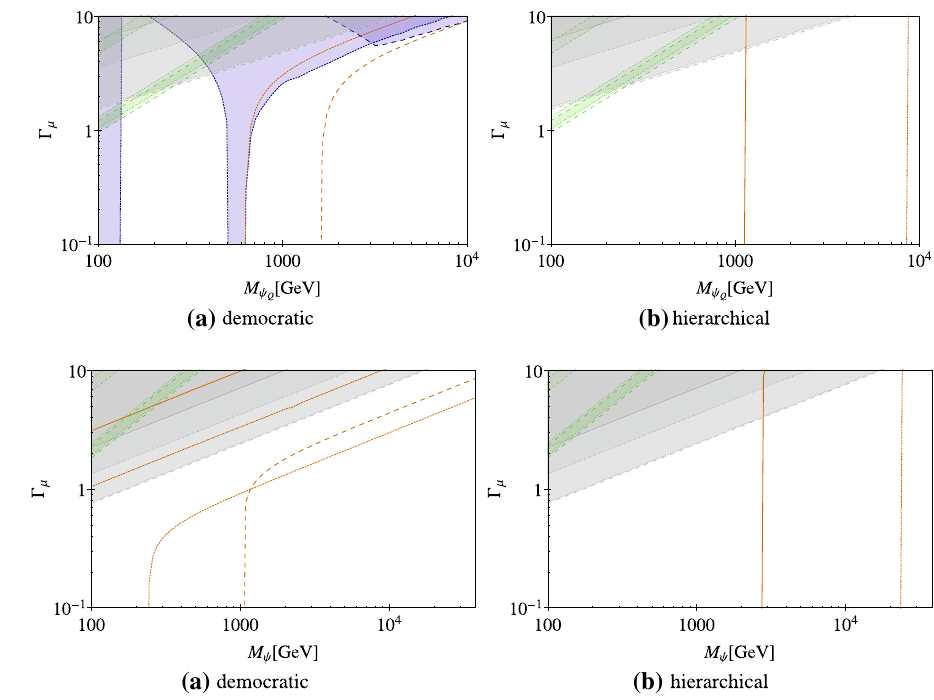
Fig. 13 Summary plot for Majorana DM in bVIB. The legend and an explanation of the color scheme are given in Fig.4